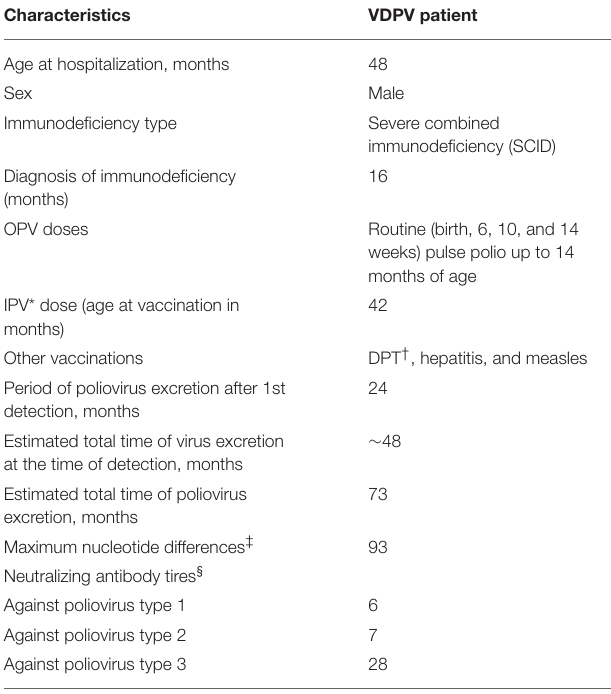
TABLE 1A | Characteristics of the SCID patient excreting vaccine-derived